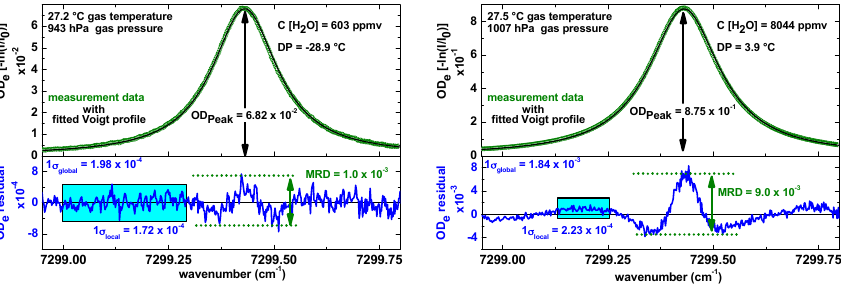
Figure 3. Typical pre-processed absorption signals from SEALDH-II for two different concentrations after baseline, offset, and transmission correction. The green dots are the measurement data, the black line is the multi-line Voigt fit, and the blue line is the associated fit residual. The laser modulation frequency was 140 Hz; 20 individual raw scans are pre-averaged yielding 7 [H 2 O] measurements per second. Abbreviations: DP = dew point of H 2 O, C = concentration of H 2 O, MRD = maximum residual deviation (see definition in [20]), OD = absorbance.